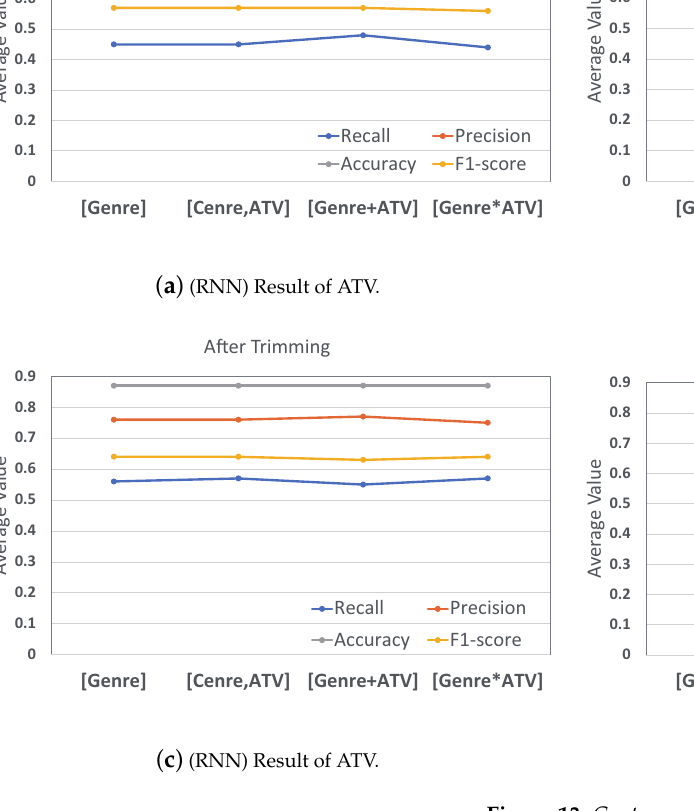
( b ) (RNN) Result of ATV.